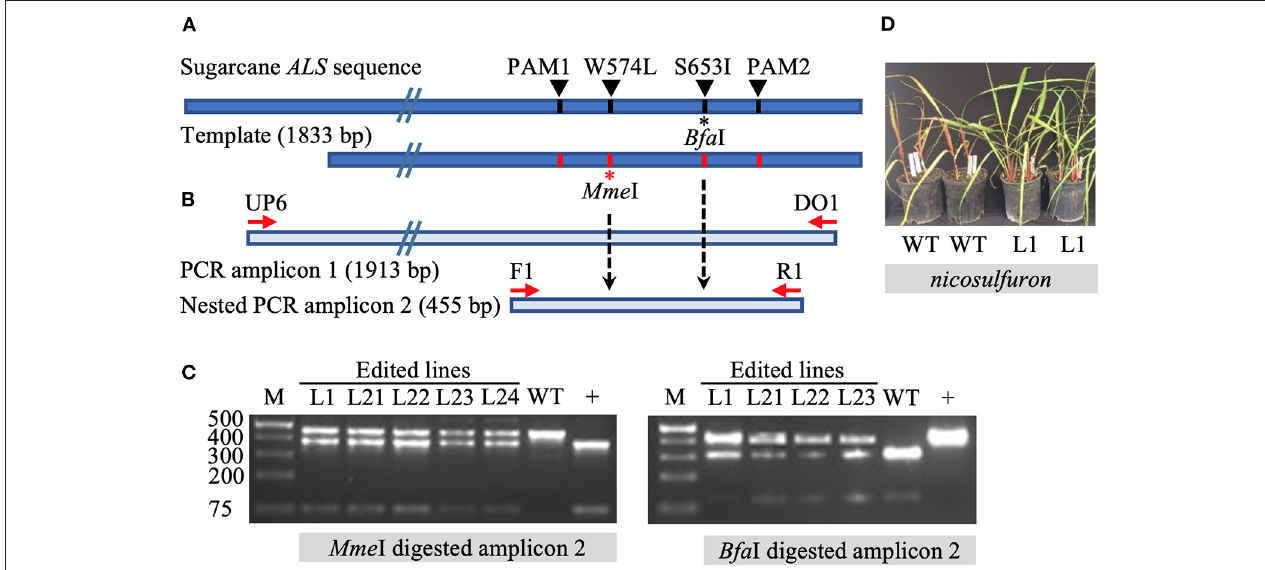
FIGURE 1 | Identification of gene targeting in sugarcane by restriction endonuclease assays and herbicide application. (A) Repair template compared to sugarcane acetolactate synthase ( ALS ) gene. The 1,833 bp template carries four nucleotide substitutions, one at the codon positions W574L (introducing the Mme I recognition site) and S653I (eliminating Bfa I recognition site), as well as two modified PAM sites (PAM1 and PAM2) (preventing template cleavage by Cas9 complexed with sgRNA1 or sgRNA2). Amino acid residue numbering in the sugarcane ALS gene follows the Arabidopsis nomenclature. (B) Schematic representation of primer annealing positions. Primers DO1 and UP6 were used to amplify a 1,913 bp fragment. Using primer UP6 prevented amplification of randomly inserted template by annealing outside the repair template. Primers F1 and R1 were used to generate a 455 bp nested PCR amplicon for analyses by restriction enzyme digestion. (C) Restriction-digestion pattern of nested PCR amplicons from wild-type (WT) and edited lines after digestion with Mme I or Bfa I. + indicates positive control that includes the Mme I site and lacks the Bfa I site. (D) Vegetatively propagated edited line L1 with multi allele conversion of W574L and S653I was tolerant to application of the herbicide nicosulfuron (Accent ® DuPont) at 95g ha − 1 , in contrast to non-edited WT